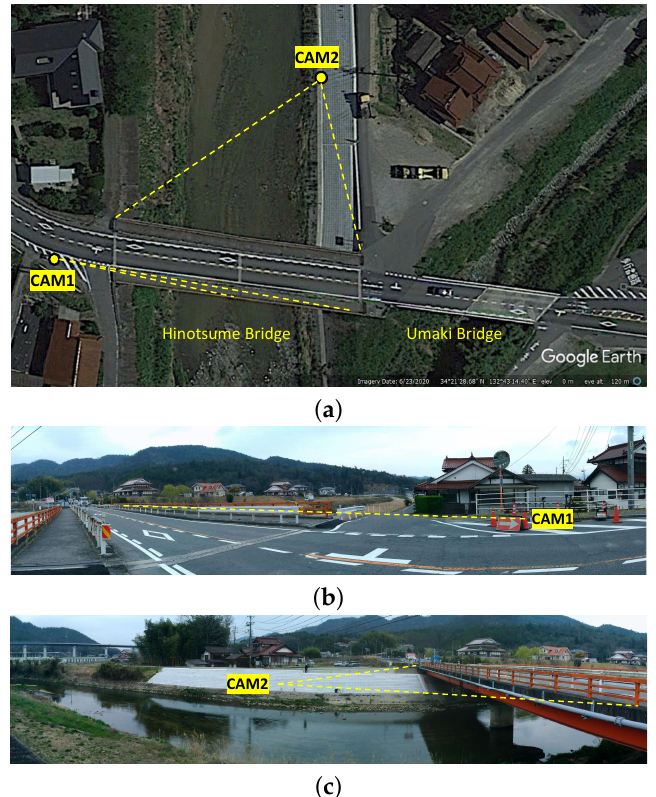
Figure 2. Field of view from the top view ( a ) of the displacement measurement camera (CAM1) ( b ) and traffic counting camera (CAM2) ( c ). The displacement measurement camera was positioned 64.2 m westward from the furthest marker installed on Hinotsume Bridge. The traffic counting camera was placed northward by the riverbank away from the bridge’s